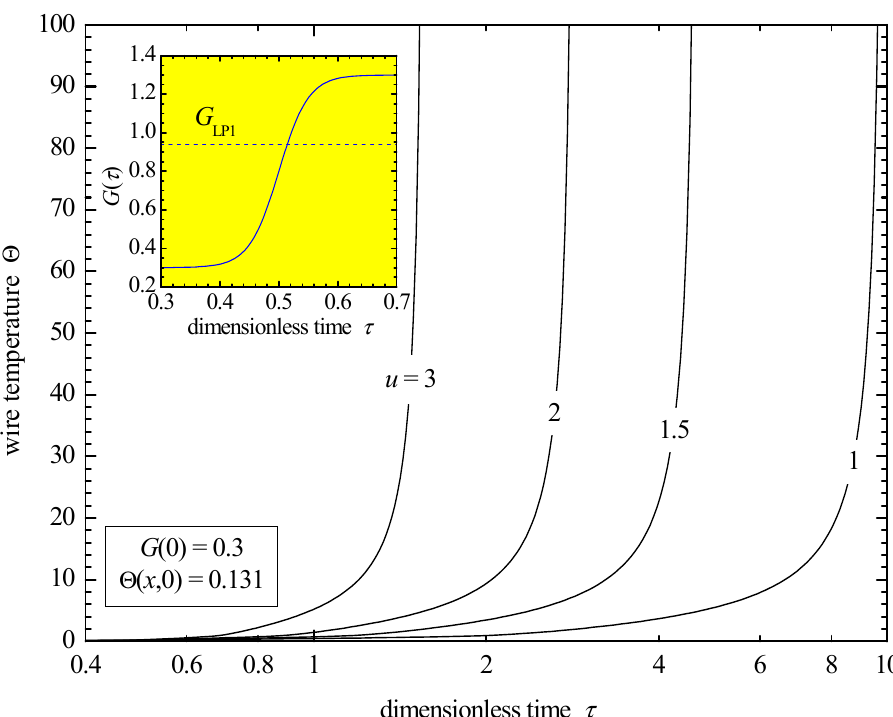
Figure 11. Temperature blow-up for a step-like change in the generation number.